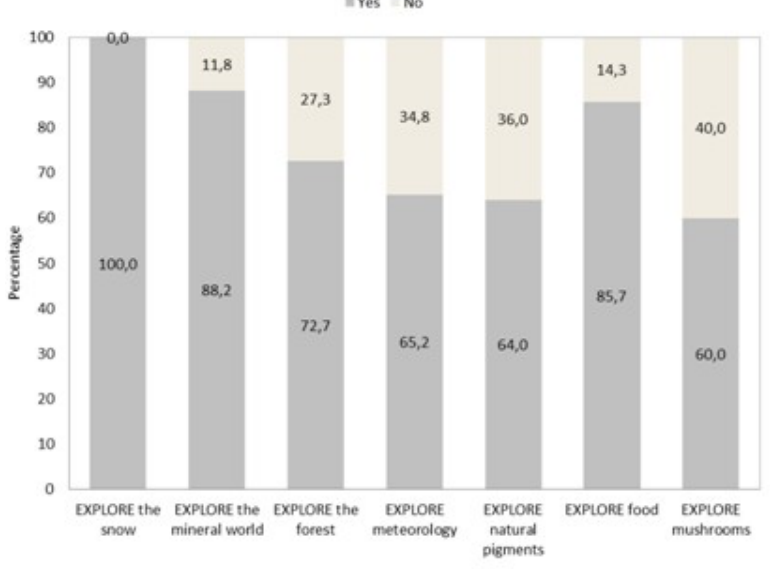
Figure 5. Percentage of responses to the queston: "Will you introduce